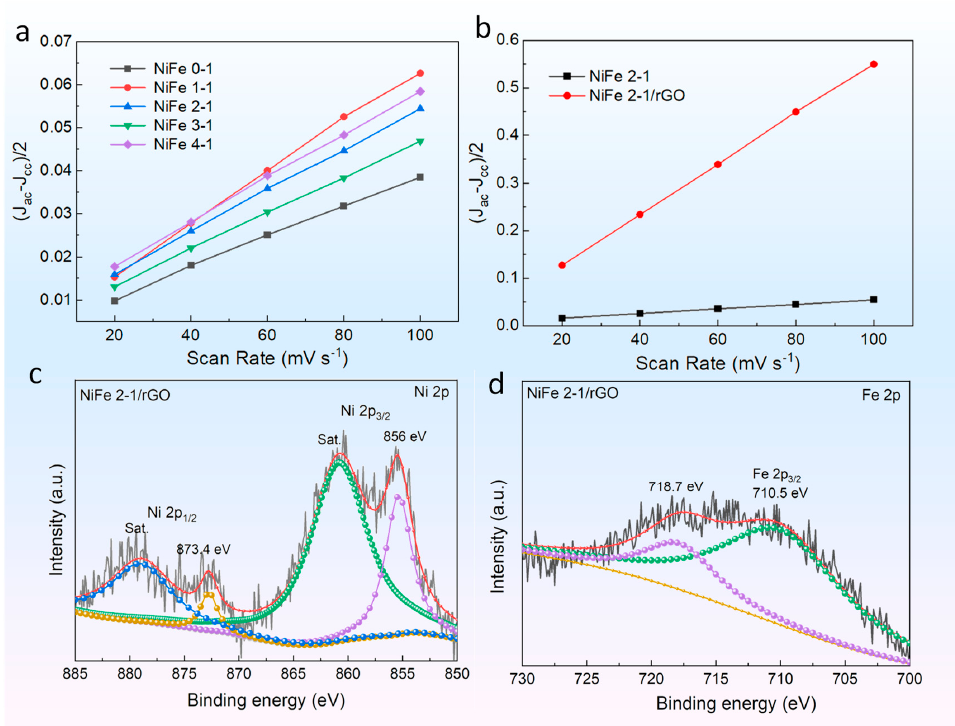
Figure 4. The linearly fitted Cdl results of electrodes. ( a ) PBA NiFe x-1; ( b ) PBA NiFe 2-1 and PBA NiFe 2-1/rGO electrodes; ( c , d ) XPS spectra of samples after OER measurement. High-resolution Ni 2p and Fe 2p spectra of PBA NiFe 2-1/rGO, respectively.